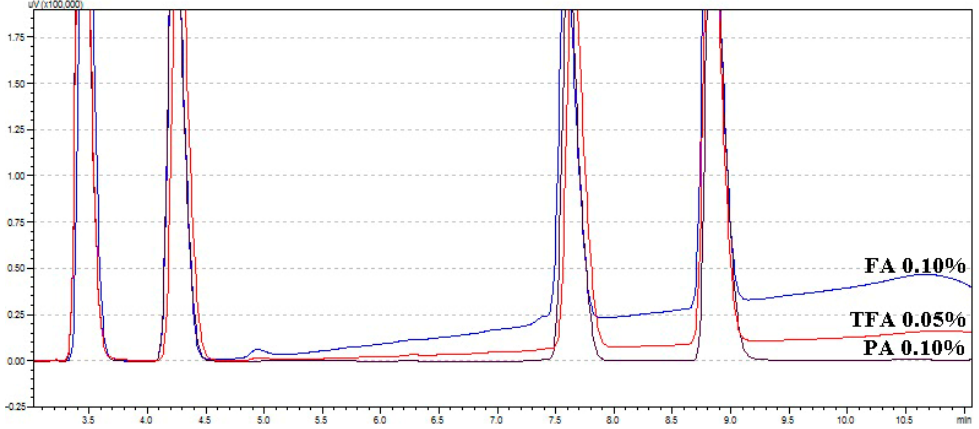
Figure 4. Analysis of four standards (100 µ g/mL) under gradient conditions including acid. Blue line, 0.10% formic acid (FA); red line, 0.05% trifluoroacetic acid (TFA); black line, 0.10% phosphoric acid (PA).